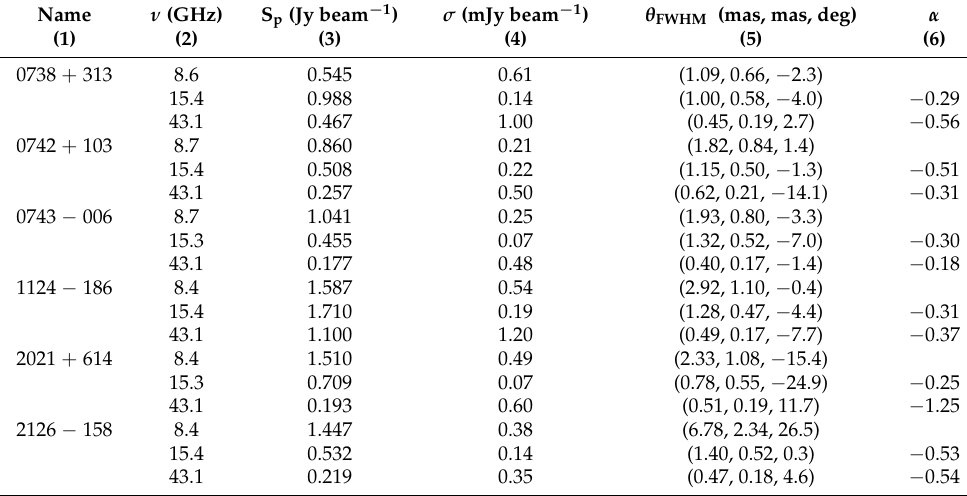
Figure 1. VLBI images at 8, 15, and 43 GHz and radio SEDs of the nine GPS sources. The peak intensity and lowest contour level ( ∼ 3 σ ) are listed in Table 2. The contours increase in a step of 2. The grey-colored ellipse in the bottom-left corner of each panel denotes the restoring beam. The yellow-colored boxes indicate the image zone shown in higher-frequency images. The total flux densities of the entire source, measured by the connected interferometers or single dishes, are obtained from the NED and used to plot the radio spectrum. A function of the self-absorbed synchrotron radiation [15] is adopted to fit the radio spectrum data, shown as red-colored lines. Table 2. VLBI image